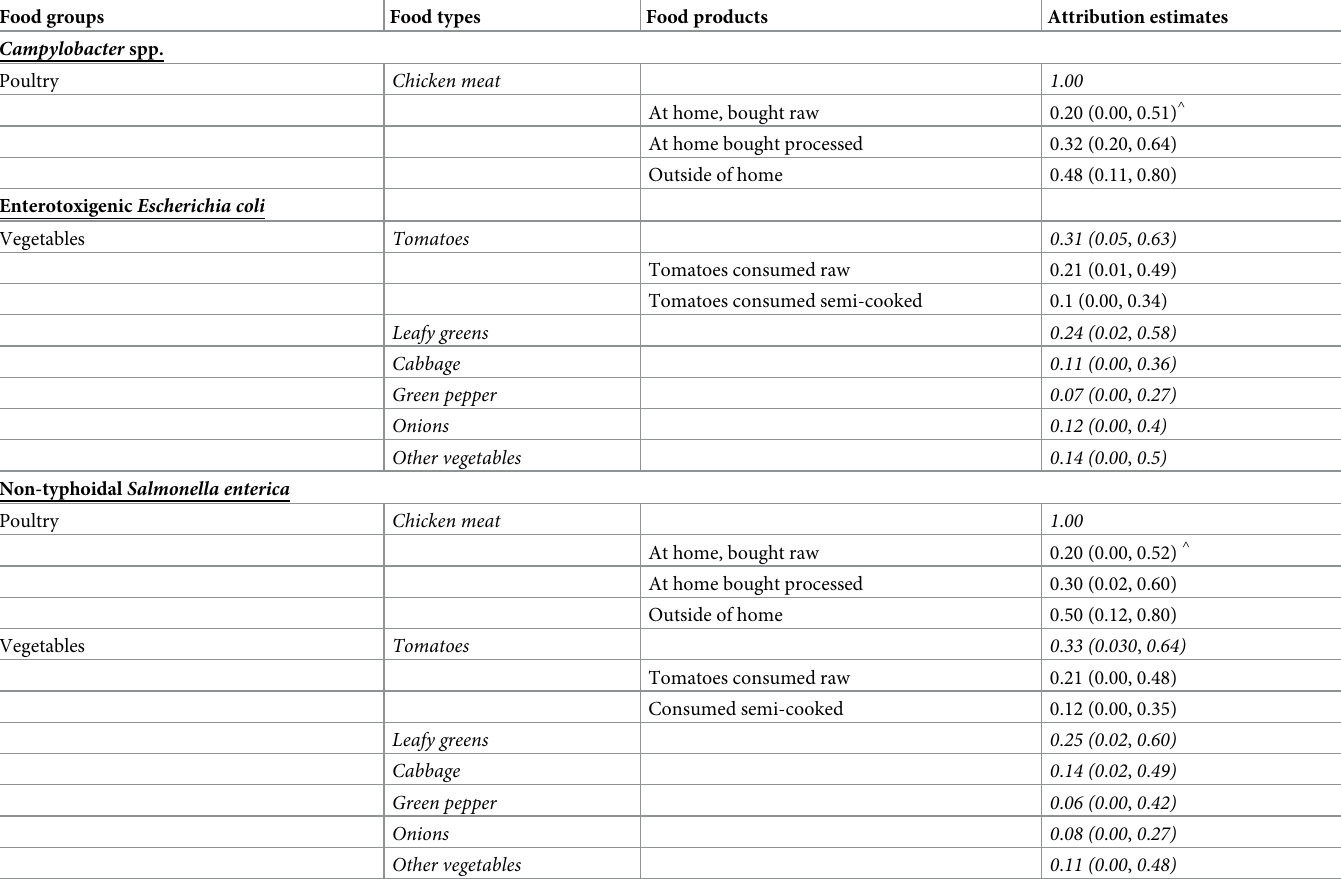
Table 7. Attribution of foodborne disease in Burkina Faso to food types, and food products. Food groups Food types Food